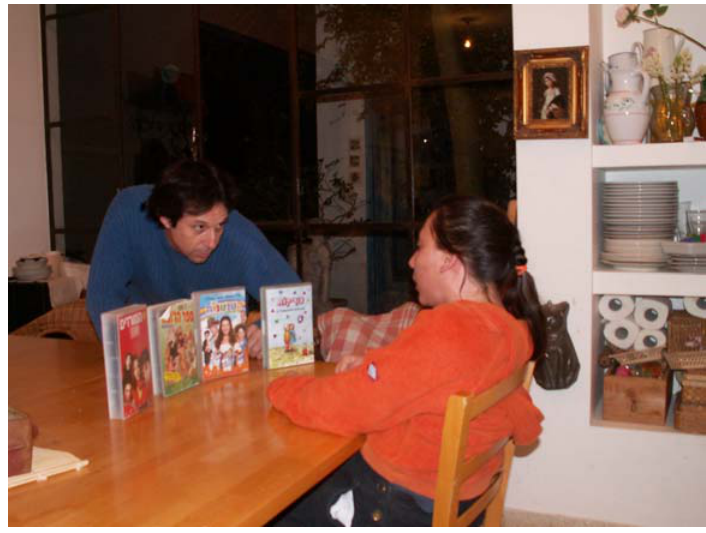
FIGURE 1. Empowering the child by enabling choice before initiation of physical therapy